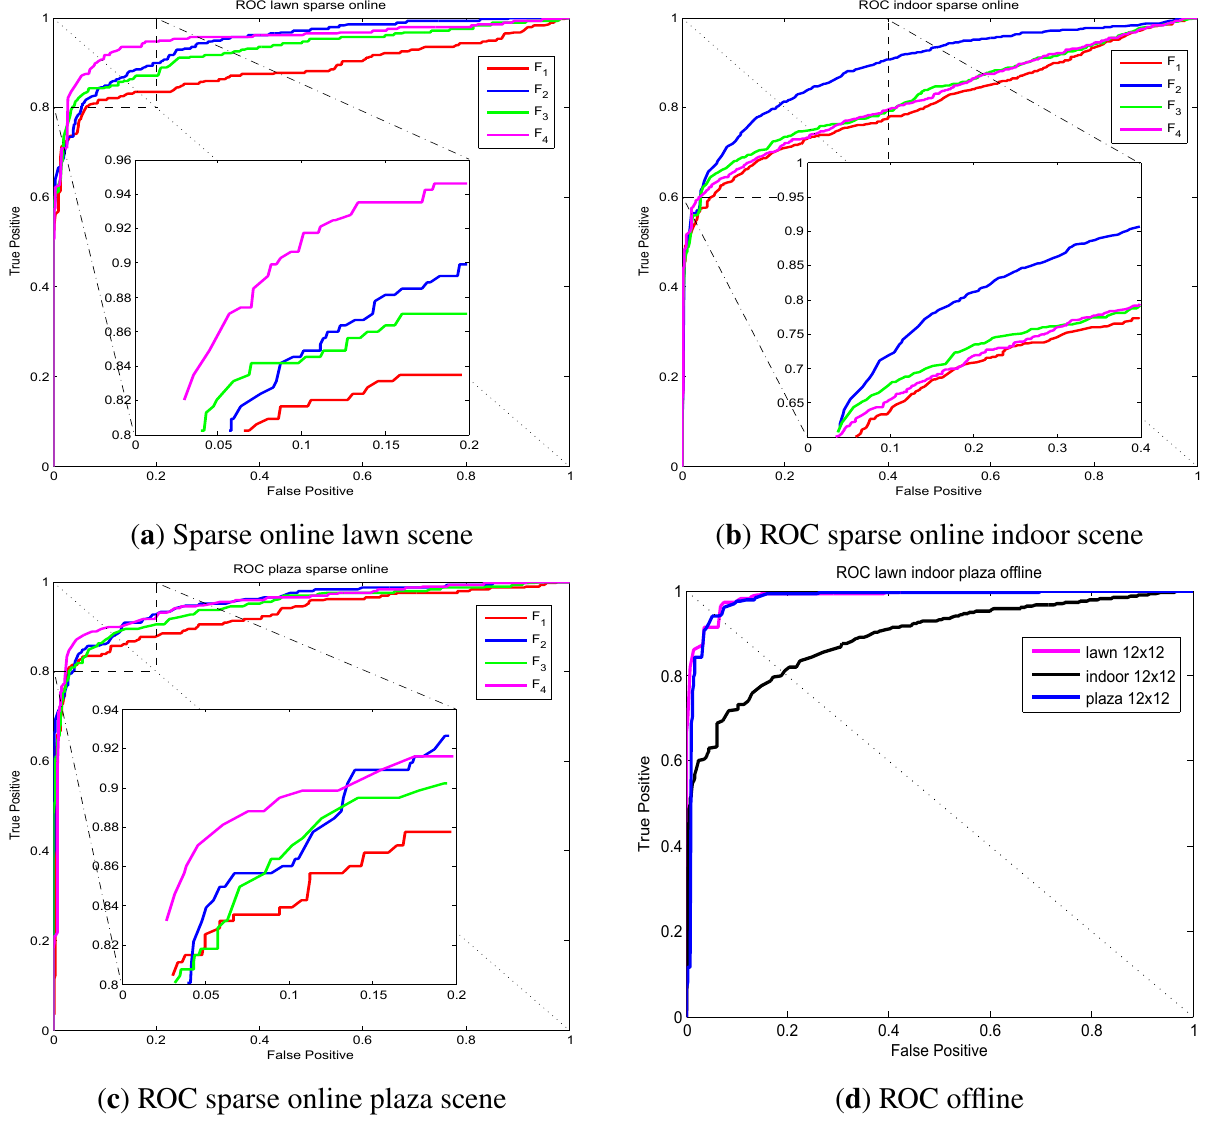
Figure 10. ROC curve of University of Minnesota (UMN) dataset. ( a ) Sparse online LS-OC-SVM results in the lawn scene. The biggest AUC value is 0.9510; ( b ) Sparse online LS-OC-SVM results in the indoor scene. The biggest AUC value is 0.8886; ( c ) Sparse online LS-OC-SVM results in the plaza scene. The biggest AUC value is 0.9515; ( d ) The ROC curve of the best performance of the lawn, plaza and indoor scene when the training samples are learned via LS-OC-SVM offline. The biggest AUC values of the lawn, indoor and plaza scene are 0.9874, 0.8900 and